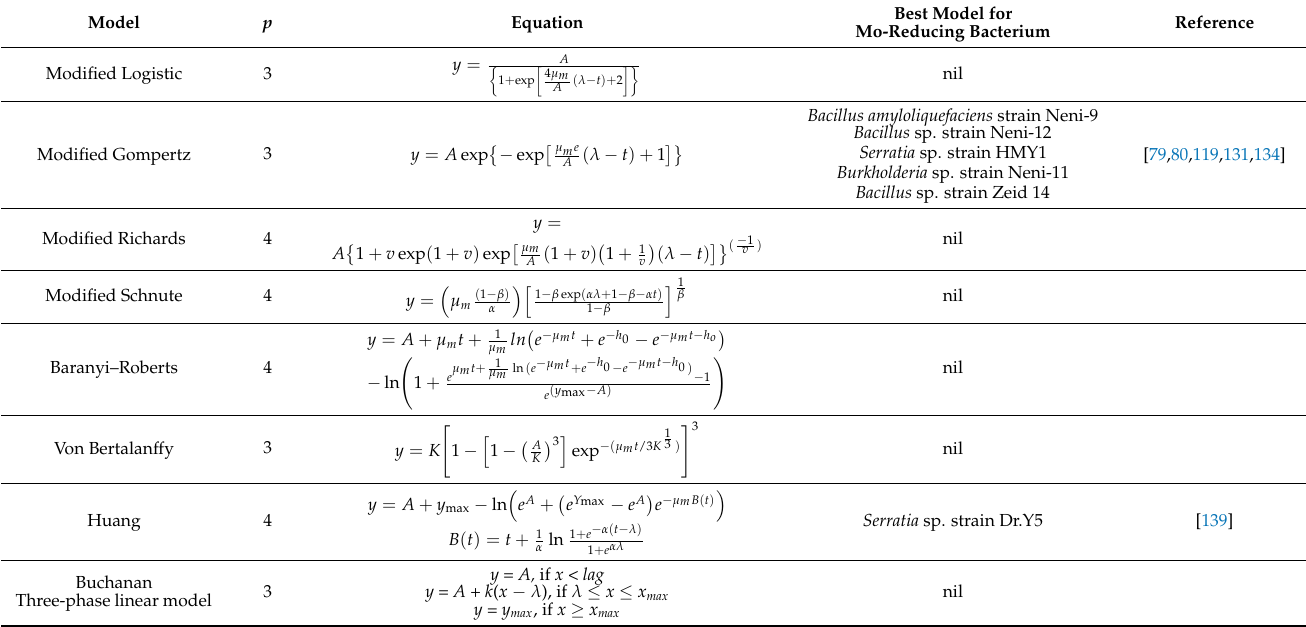
Table 2. Mo-blue production models used in some previous